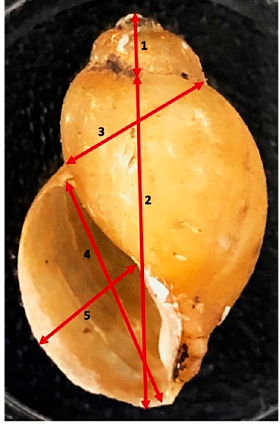
Figure 2. Measurements taken of shells. The picture of a shell shows measurements taken: (1) spire height, (2) height of snail body whorl, (3) snail breadth to body whorl to suture, (4) aperture height, (5) aperture width. (5) aperture